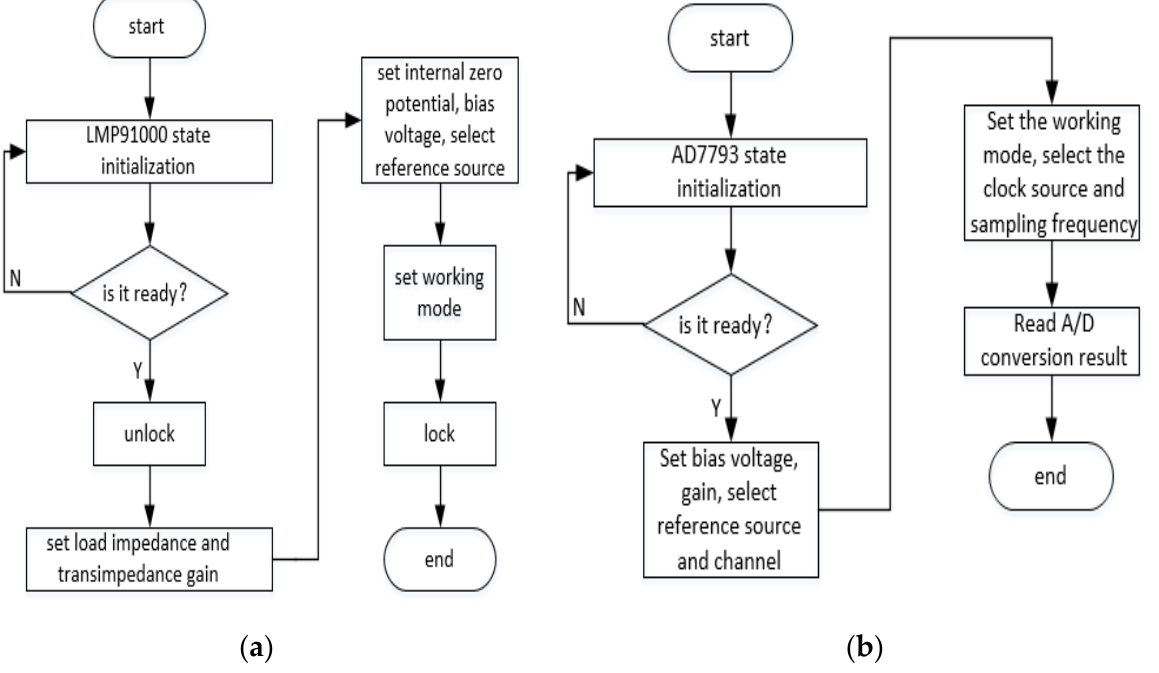
Figure 15. ( a ) LMP91000 program flow; ( b ) AD7793 program flow.